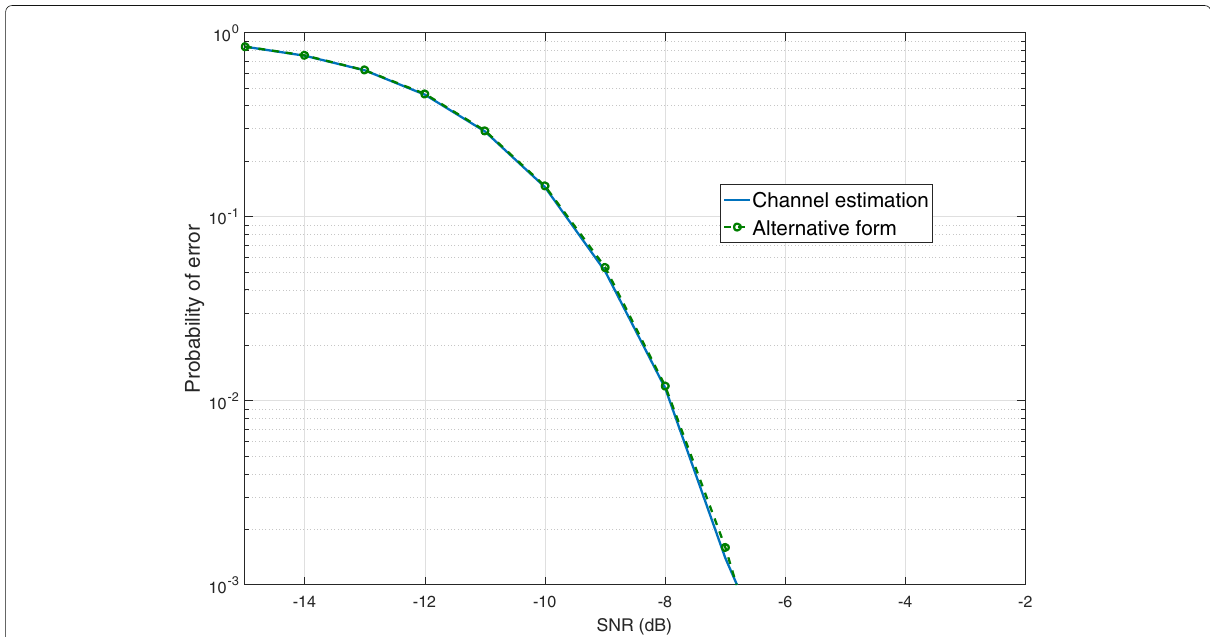
Fig. 8 Error probability versus SNR (dB) of the suggested DFT-based implementation (15) compared with the alternative form